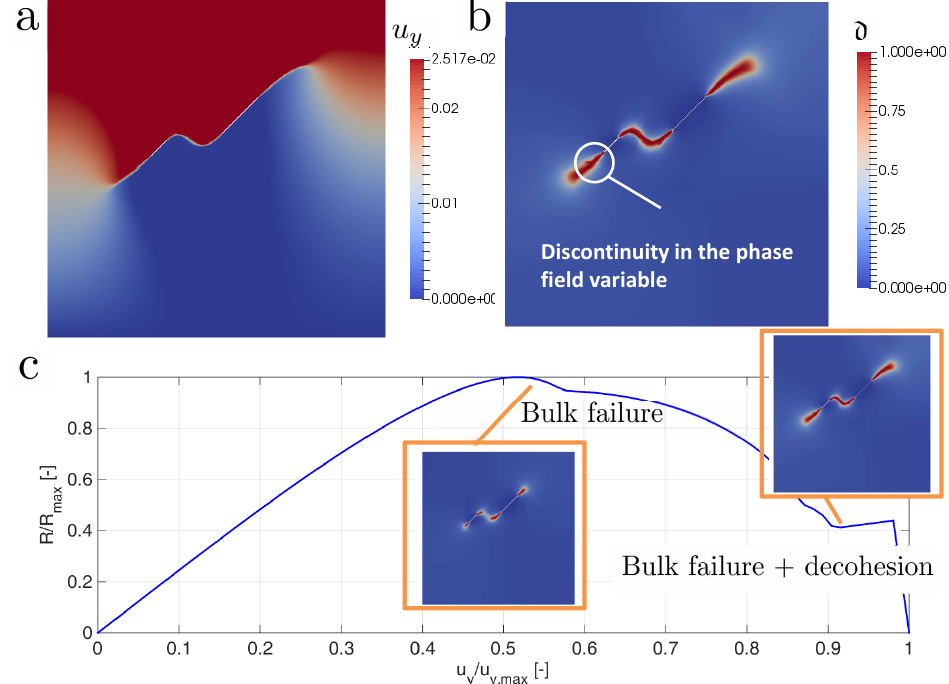
Figure 15. Specimen with 2 inclined flaws and a horizontal joint. Case ¯ u y = ¯ u x traction-traction: ( a ) vertical displacement; ( b ) damage pattern; ( c ) Load-displacement evolution curve including snapshots of the phase field